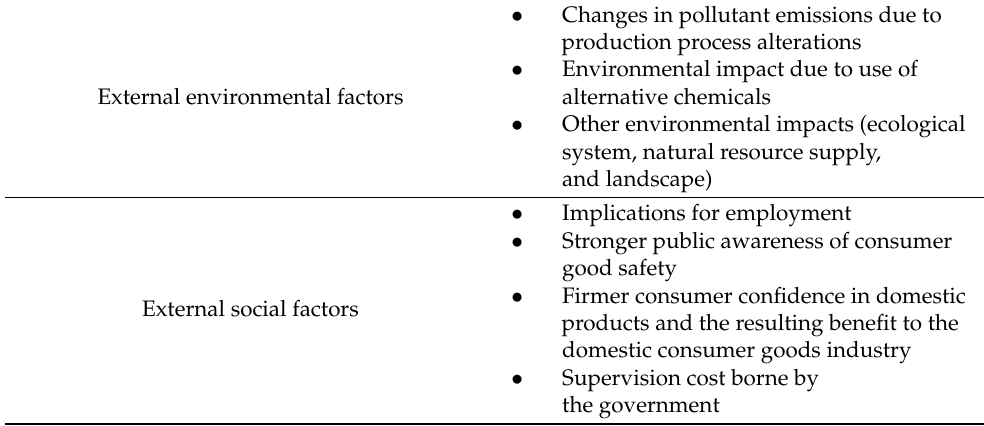
Table 2. External factors related to a general limit